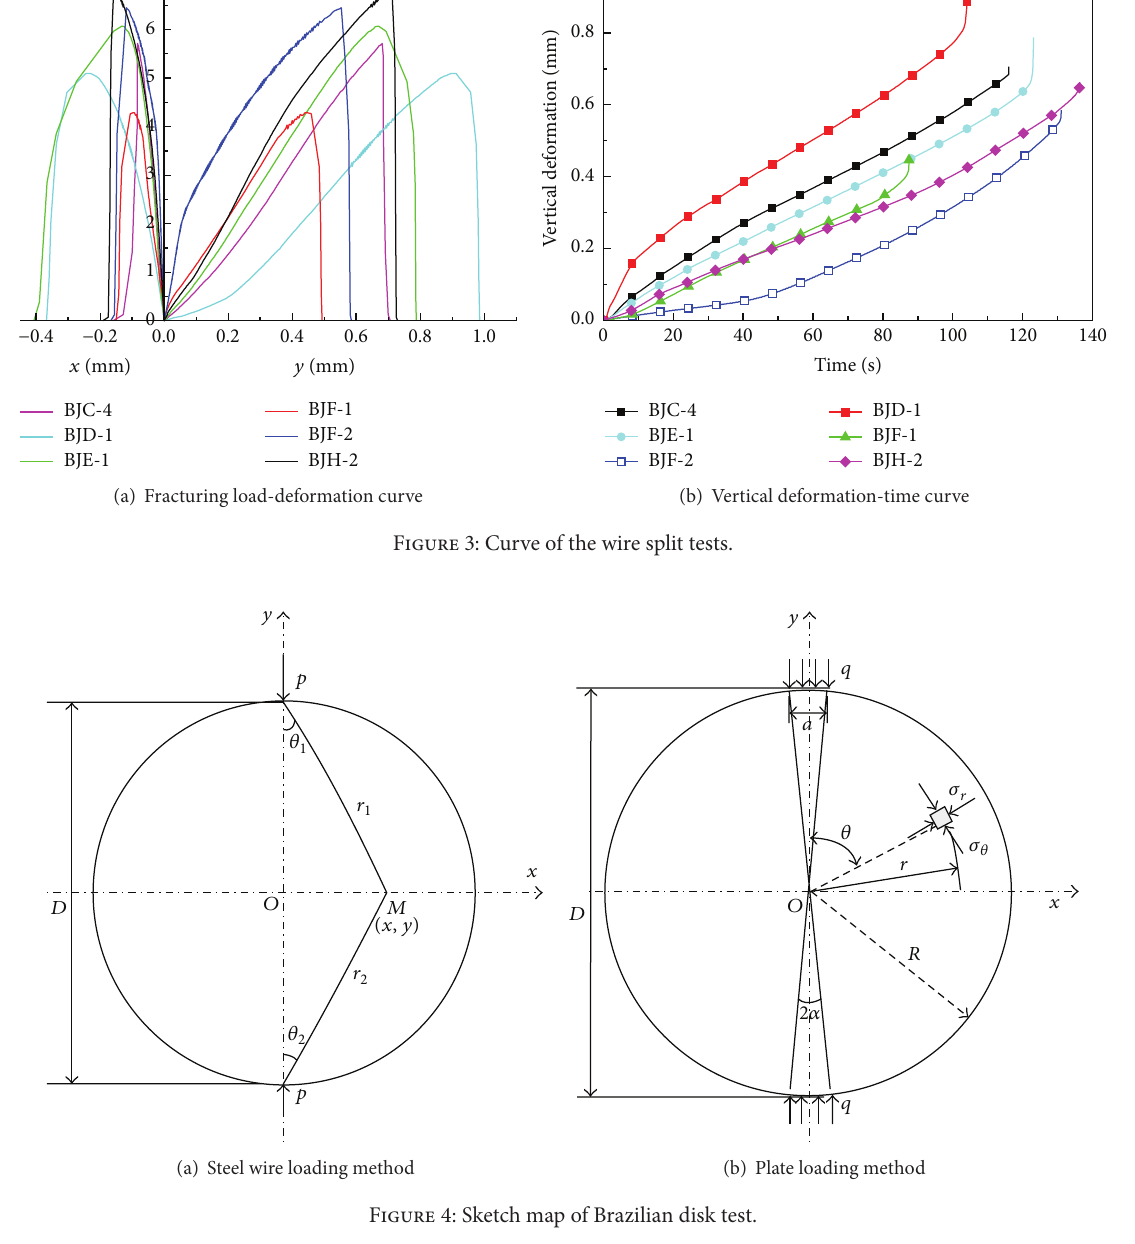
Figure 4: Sketch map of Brazilian disk